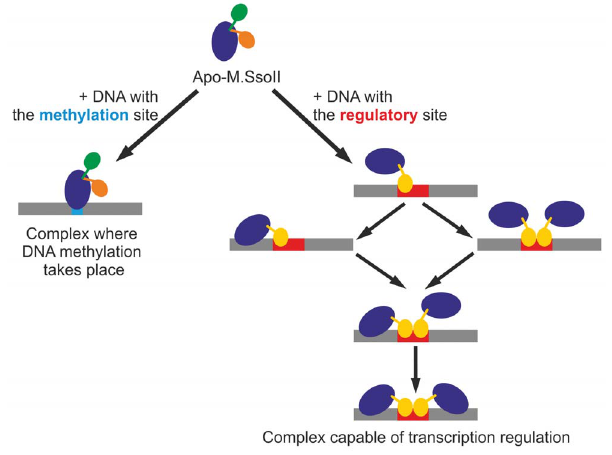
Figure 4. Possible role of the linker flexibility in M.SsoII binding to target DNA. DNA is in grey, the methylation site is in cyan, the regulatory site is in red. The MTase domain is shown in blue. Apo-M.SsoII demonstrates high linker flexibility which results in coexistence of different conformations of the N-terminal region (shown by green and orange). Upon M.SsoII binding to the methylation site, the dominant RD conformers keep the same orientations as in the apo- form. Binding to the regulatory site is supposed to be a multi-stage process which results in M.SsoII dimer formation where both domains of each M.SsoII subunit are bound to the same DNA duplex. Such structural organization is likely to fix both domains in a certain position in relation to each other. As we do not know whether the N-terminal region position in the latter complex is similar to any of the dominant RD conformers in the M.SsoII complex with the methylation site, the N- terminal region is shown by another (yellow) color in the latter case.